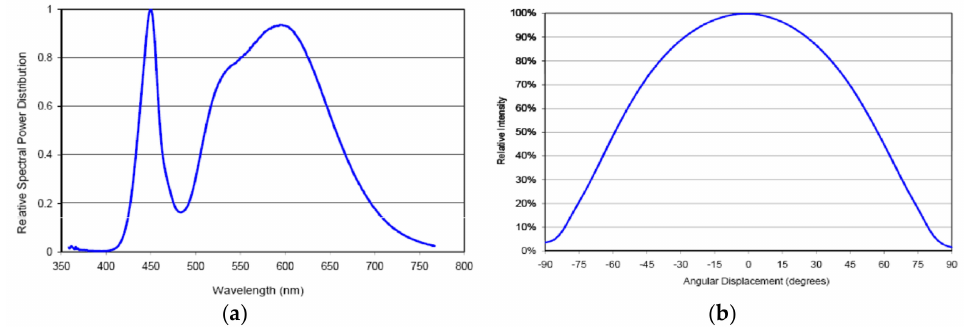
Figure 8. Optical characteristic of Rebel ES LED: ( a ) spectral power distribution; ( b ) relative intensity vs. angular displacement [37].